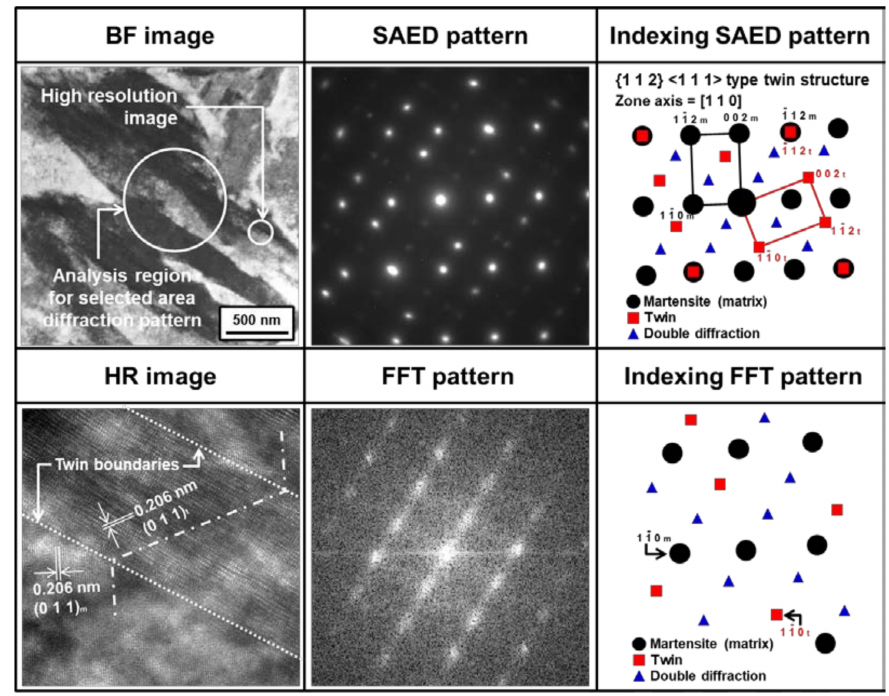
Figure 11. Representative BF and HR images of the hardening zone of P20-improved steel after laser-assisted heat treatment at 1473 K and its corresponding SAED and FFT patterns analyzed by